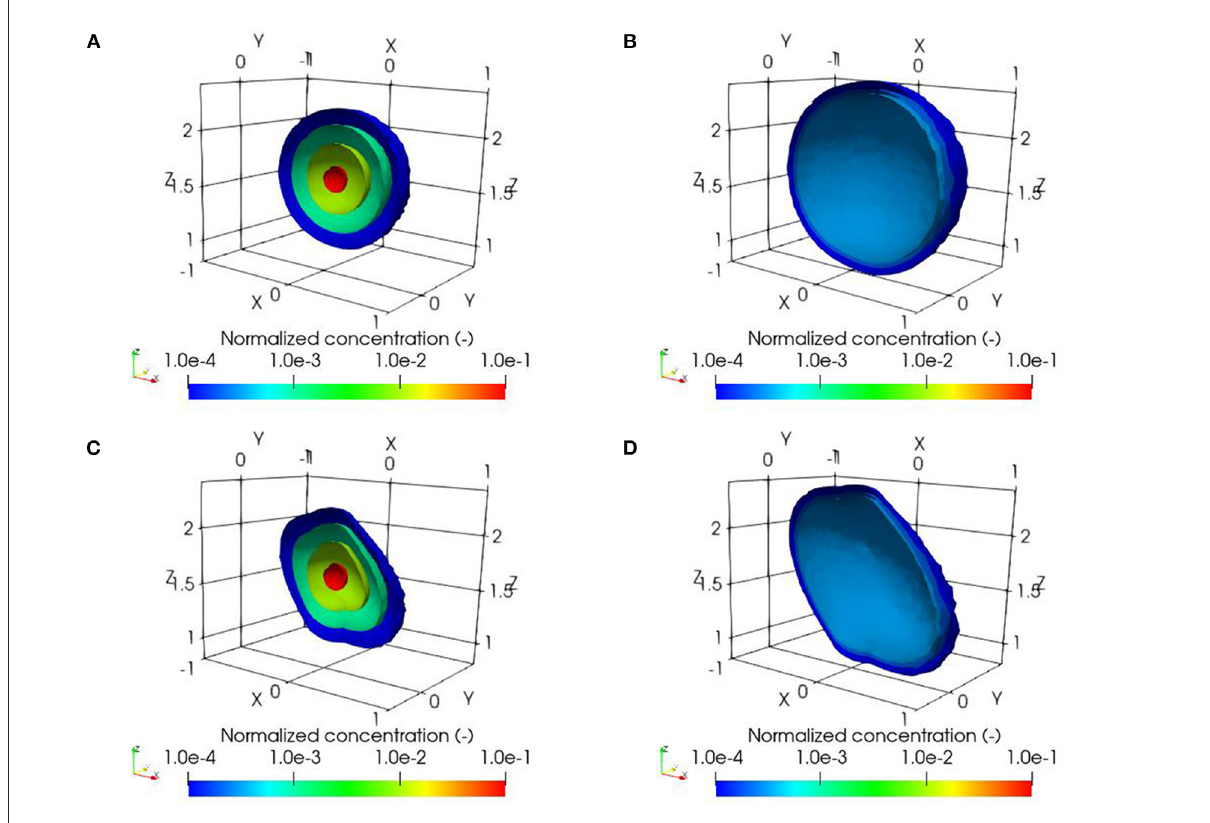
FIGURE7 Simulated normalized concentration distributions of HTO for the in-situ diffusion experiment, (A) isotropic diffusion after 837 days, (B) isotropic diffusion after 1825 days, (C) anisotropic diffusion after 837 days, and (D) anisotropic diffusion after 1825 days.